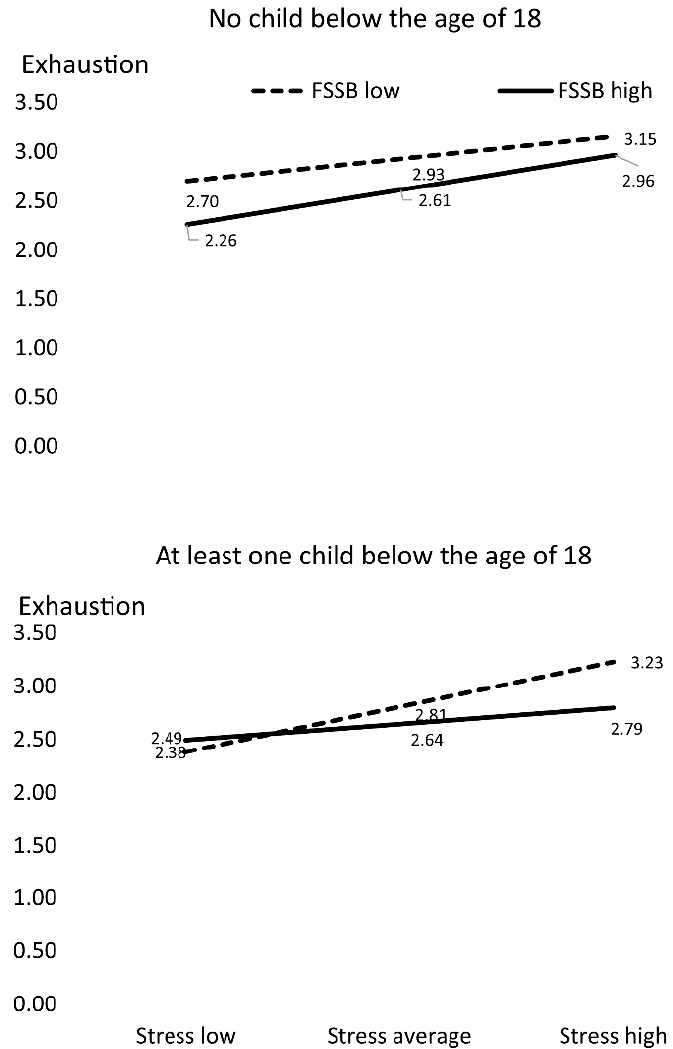
Figure 2. Interaction Stress × Family Supportive Supervisor Behaviors × Child. Dotted lines show employees who, on average, do not perceive family supportive supervisor behaviors (FSSB). Solid lines show employees who, on average, perceive FSSB. Strong work stress was associated with strong feelings of exhaustion. On average, employees who perceived FSSB experienced weaker feelings of exhaustion than did employees who did not perceive FSSB. FSSB more strongly moderated the association between stress at work and the experience of exhaustion in employees with children below the age of 18. In employees with children younger than 18, the association between work stress and exhaustion was weaker for employees who perceived FSSB than for employees who did not perceive FSSB. Having a larger number of publications and a higher H-index was linked with being employed full-time and with being older. No other variables were linked to either the publication number or the H-index (Table 4). No indirect associations between stress at work and publication number via exhaustion were detected (all β values = 0.0–0.1; lower limit of 95% confidence interval = − 0.1–0.0; upper limit of 95% confidence interval = 0.1–0.2). Similarly, no indirect links between stress at work and the H-index via exhaustion were found (all β values = − 0.1–0.0; lower limit of 95% confidence interval = − 0.3– − 0.1; upper limit of 95% confidence interval =